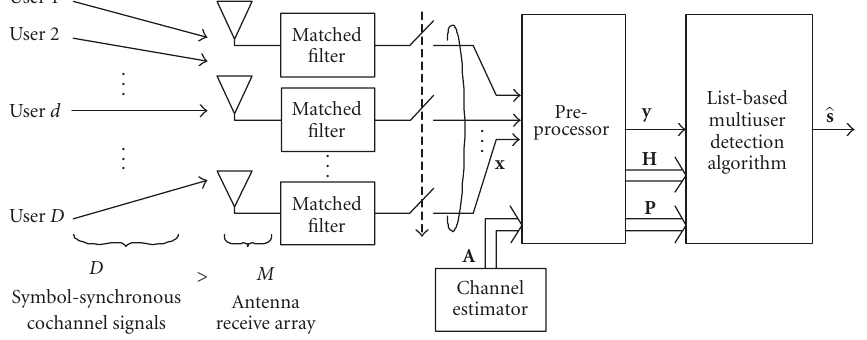
Figure 1: Receiver structure.